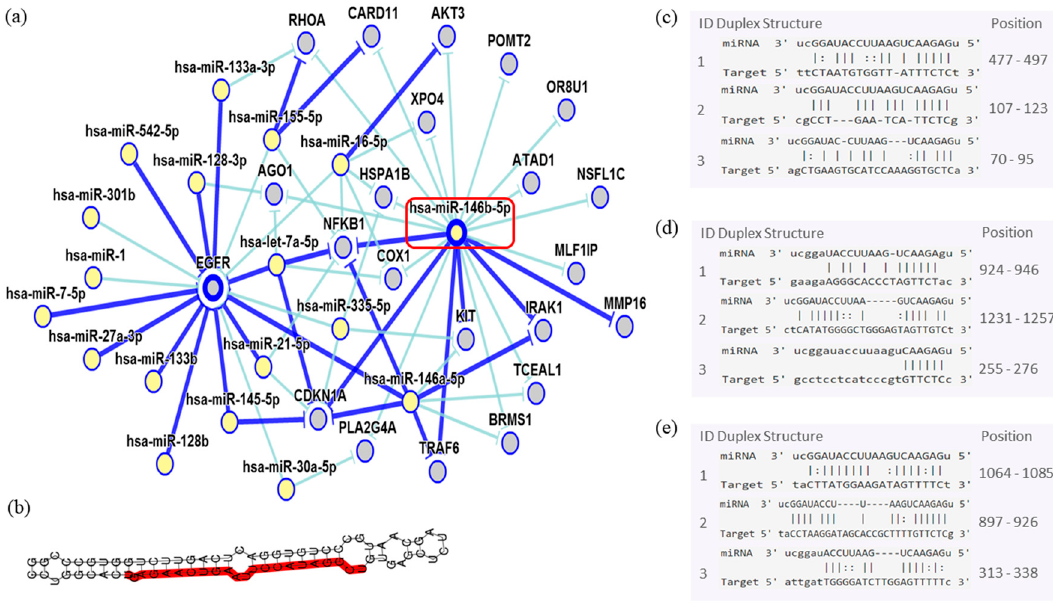
Figure 9. Interaction network of miR-146b- 5p. ( a ) The mRNA showed a strong modulation of NFKB1 and CDKN1A , and an indirect interaction with EGFR . ( b ) Molecular structure: pre-miRNA hairpin of miR-140b- 5p, second structure of pre-miRNA, and, in red, mature sequence 9|UGAGAACUGAAUUCCAUAGGCU|30. ( c – e ) miRNA sequence of target interactions with NFKB1, CDKN1A and EGFR , respectively, showing the position in the gene sequence. Dark blue shows strong evidence (reporter assay, Western blot, qRT-PCR, or qPCR), and light blue shows other evidence.